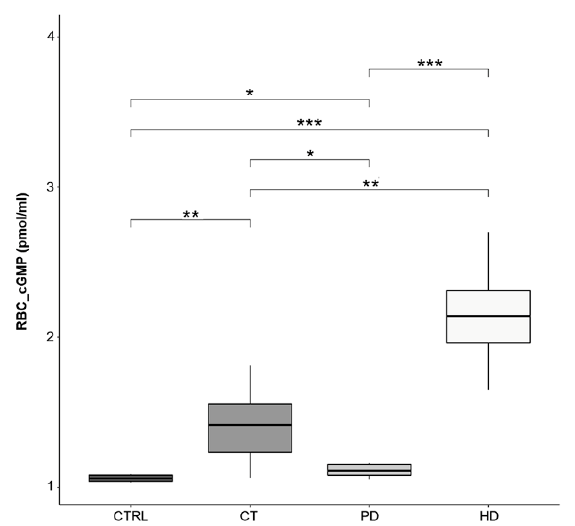
Figure 2. RBC cGMP levels. Box plots represent intra-erythrocytes cGMP levels in the four study groups (CTRL, CT, PD, HD; N = 10 for each group). cGMP concentration was evaluated through ELISA and expressed as picomoles/milliliters (pmol/mL). Horizontal black lines indicate the medi- ans, boxes the interquartile range (IQR) and the bottom and top whiskers represent the minimum and maximum values. (* p < 0.05; ** p < 0.01; *** p < 0.001).